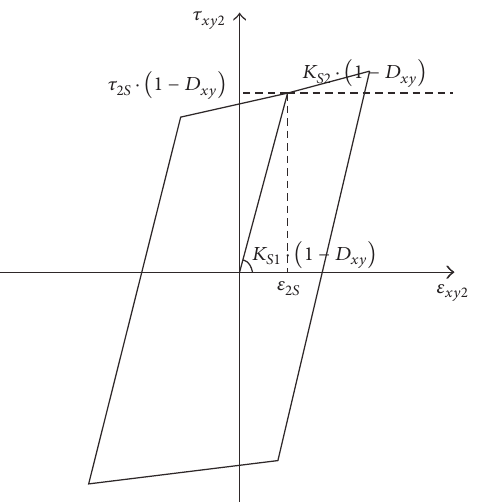
Figure 6: The hysteresis loop for the panel in 𝑋𝑌 plane in the local coordinate